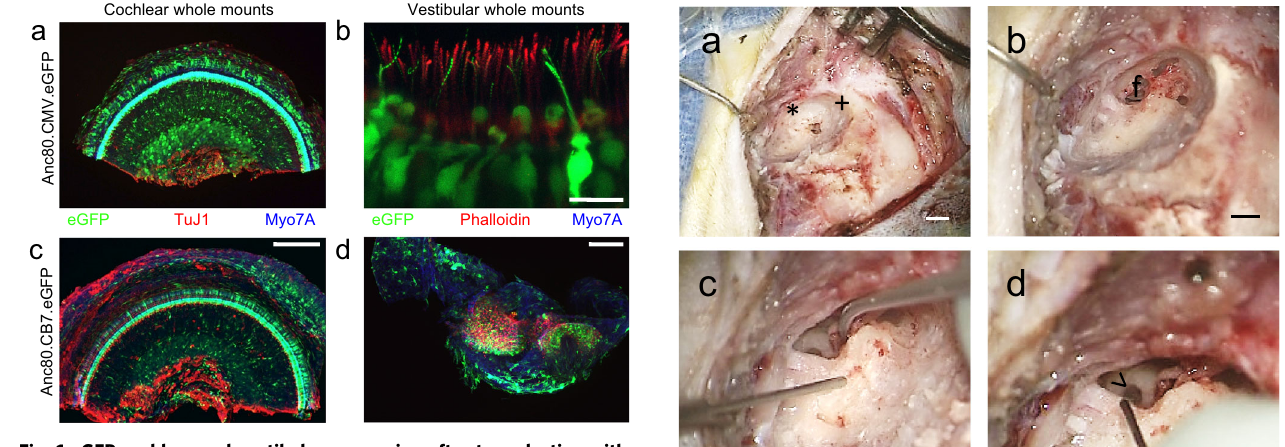
Fig. 1 eGFP cochlear and vestibular expression after transduction with vectors with the same transgene driven by CMV or CB7 promoter.